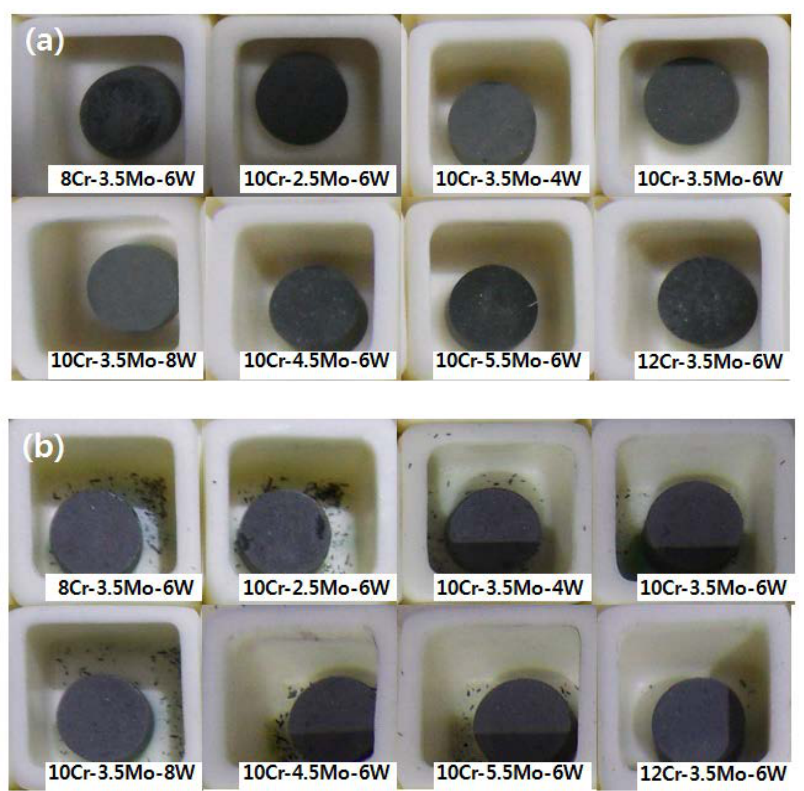
◦ C and ( b ) at 1000 ◦